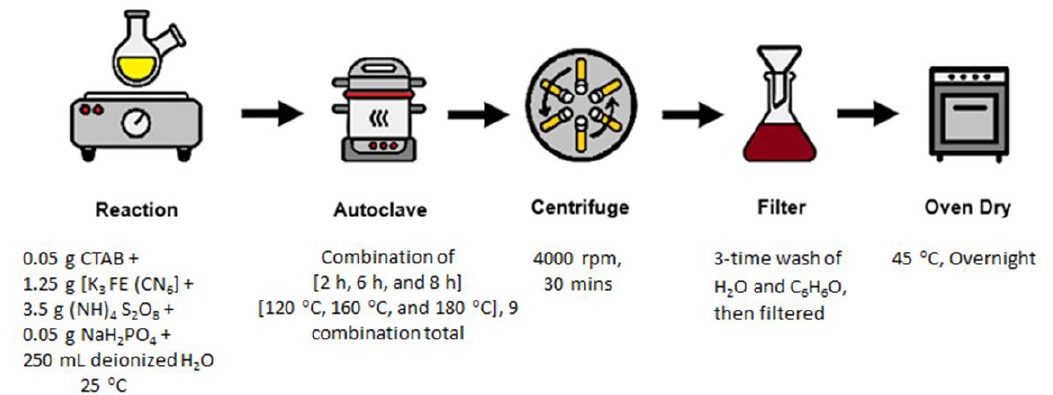
Figure 1. Schematic of the synthetic strategy employed to synthesize α -Fe 2 O 3 and Fe 3 O 4 (NHS), with synthetic parameters for each step listed.